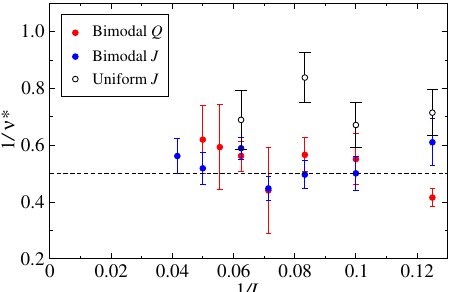
FIG. 16. Binder cumulants vs the inverse system size at the ð L; 2 L Þ crossing points for systems with bimodal Q and J distributions as well as a uniform distribution of J from the range [0, 2]. The line is a collective fit to the data for the two bimodal